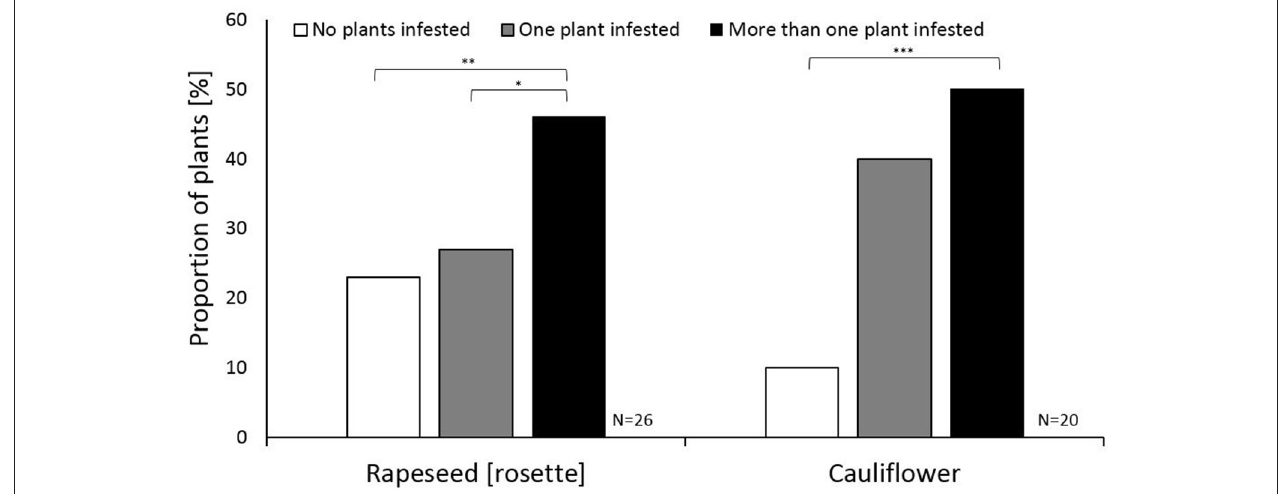
FIGURE 2 | The host acceptance strategy of individual Contarinia nasturtii females on cauliflower and rapeseed (rosette) plants in the host acceptance assay. White, gray, and black bars indicate the proportion of C. nasturtii laying no eggs, ovipositing on only one plant, or ovipositing on more than one plant. The Y-axis shows the proportion of females choosing a certain oviposition strategy. Nominal logistic regression was used for comparing cauliflower and rapeseed with significant differences marked with asterisks as follows: * P < 0.05; ** P < 0.01; *** P < 0.001. n = 20–26 for each plant type.